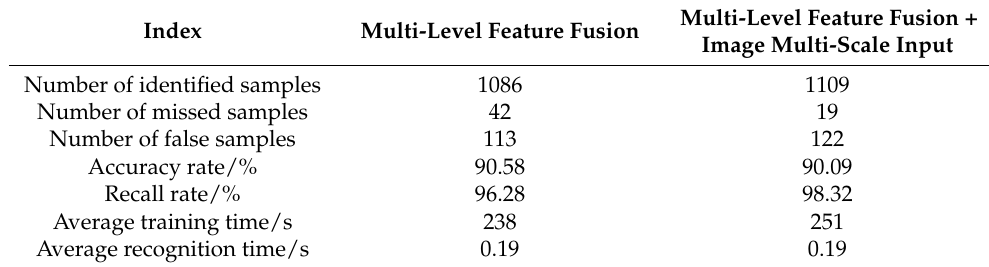
Table 4. ReliefholetargetrecognitionresultsbasedonimprovedSqueezeNet+BNwithdifferentmeasures.